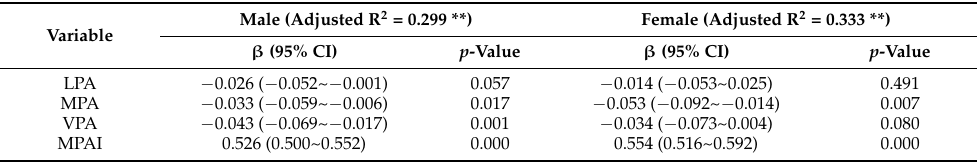
Table 3. The Pearson correlation coefficient for the degree of irrational procrastination exhibited by participants (IPS score) and across different groups.